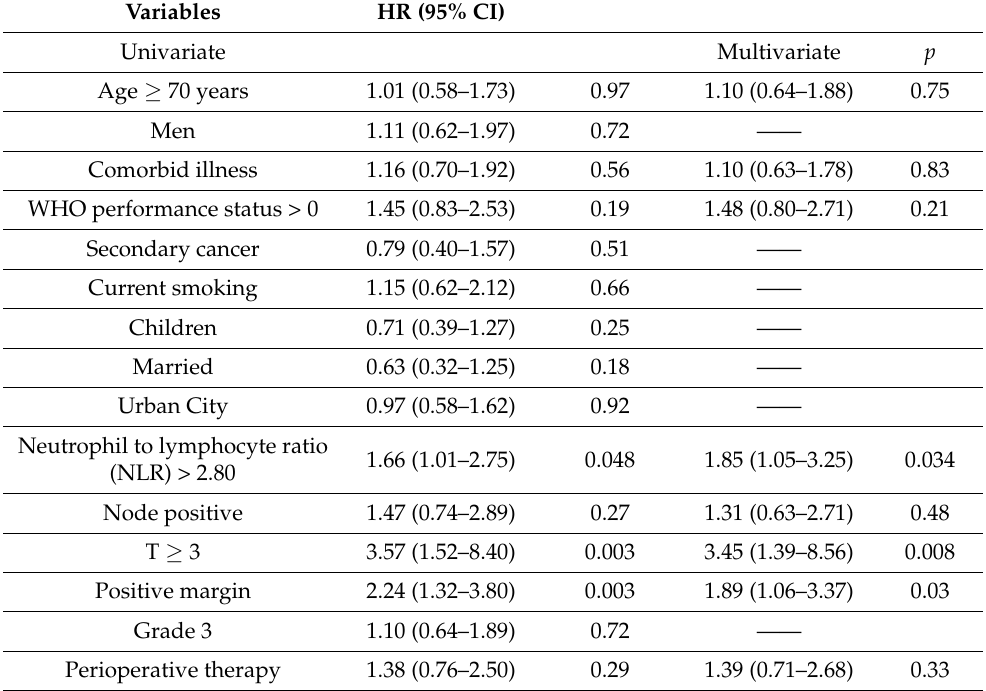
Table 3. Univariate and Multivariate Cox Proportional analyses for relationship between various clinical and pathological variables and mortality. A value greater than 1 suggests an increased risk whereas value lower than 1 suggests decreased risk.